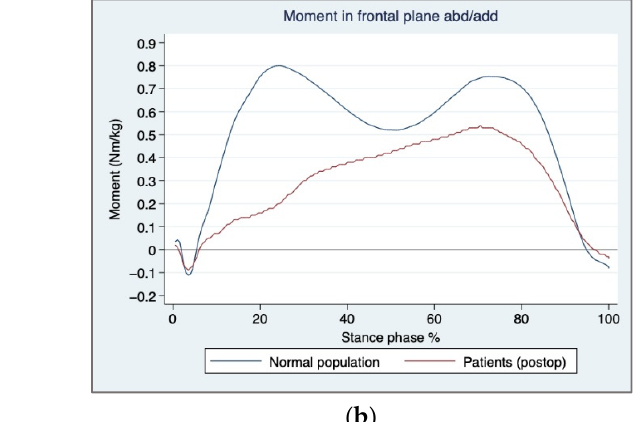
Figure 2. Hip abduction moment in the frontal plane: ( a ) Pre-and postoperative hip abduction moment during stance in patients, ( b ) Normal population and postoperative patients, hip abduction moment during stance.